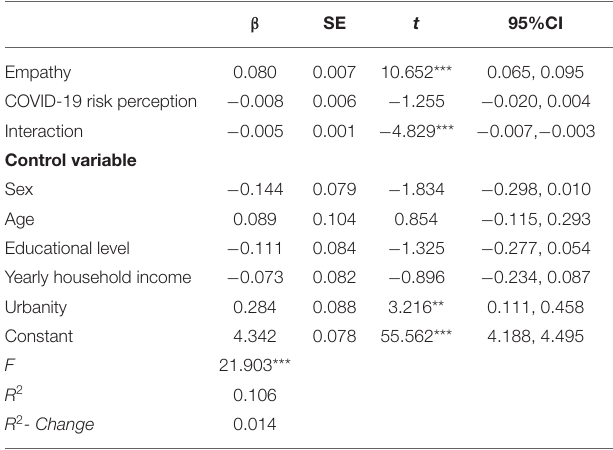
TABLE 3 | Moderating effect of COVID-19 risk perception on the relationship between empathy and COVID-19 volunteer